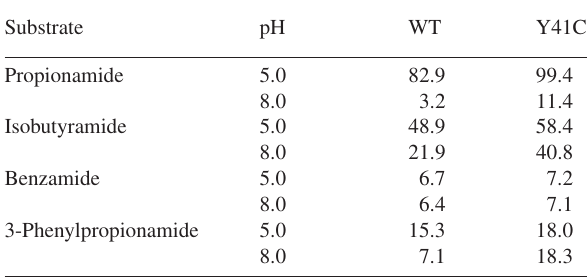
Table 7. Turnover numbers (k cat , s –1 ) for Sulfolobus solfataricus WT amidase and Y41C determined at pH 5.0 and pH